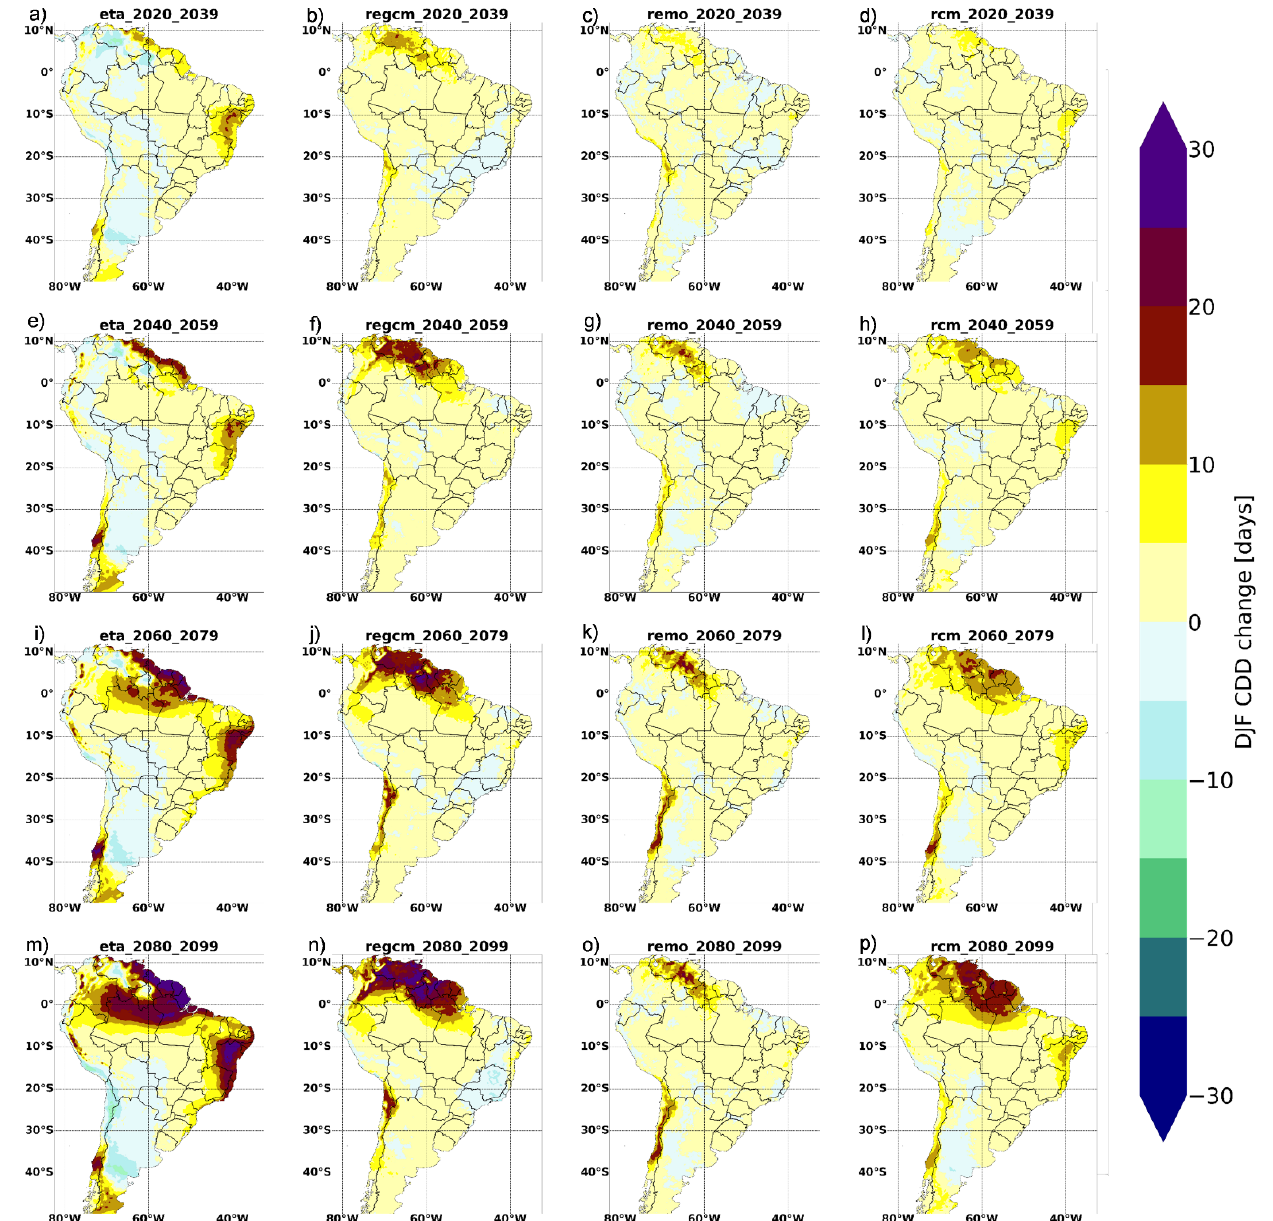
Figure 9. Changes projected to CDD (days) during austral summer computed from each RCM ensemble (Eta, RegCM, and REMO) and 3RCMs ensemble (right column) and considering four timeslices: ( a – d ) 2020–2039, ( e – h ) 2040–2059, ( i – l ) 2060–2079, and ( m – p )